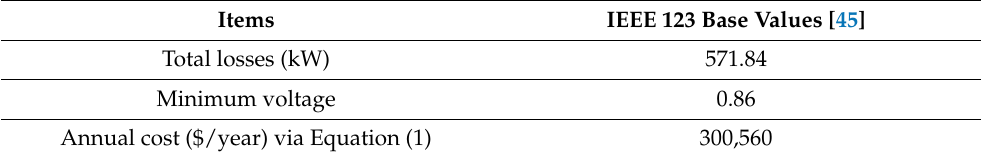
Table 10. The base data of the unbalanced IEEE 123.